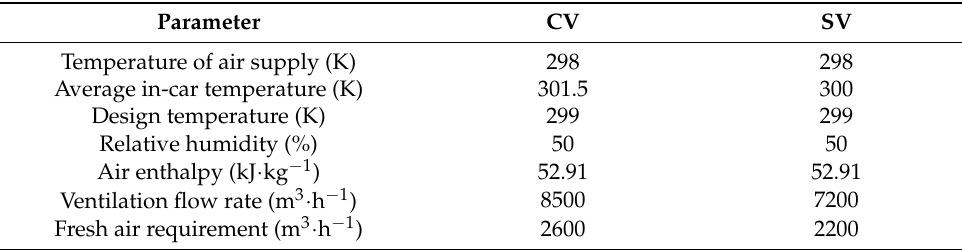
Table 2. Calculation parameters of air in the cars equipped with SV and CV in summer. Parameter